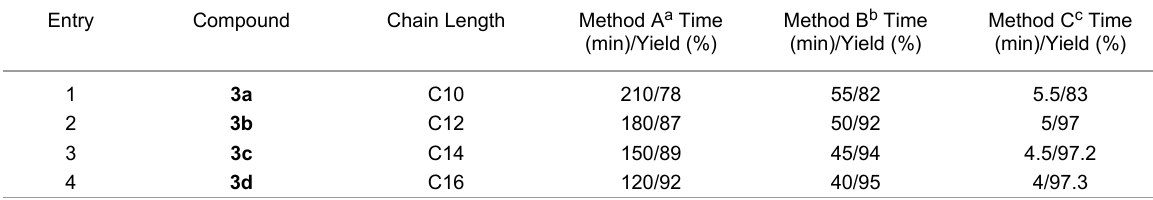
Table 1: Comparison of yields and time for the synthesis of hydroxy-substituted aliphatic amide using fatty acids R 1 = H.